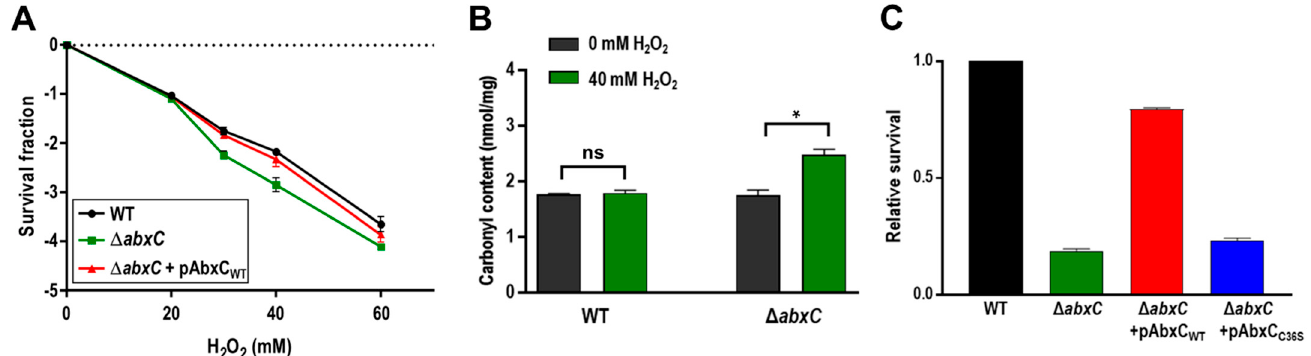
Figure 3. Effects of abxC mutation on H 2 O 2 resistance. ( A ) Survival of Δ abxC exposed to H 2 O 2 . WT, Δ abxC , and Δ abxC harboring pAbxC WT that encodes the wild-type AbxC were treated with H 2 O 2 at the indicated concentrations for 1 h. The survival fraction was calculated by dividing the CFU of H 2 O 2 -treated cells by the CFU of non-treated cells. Values are means and standard deviations of two independent experiments conducted in duplicate. ( B ) Protein carbonylation of Δ abxC in response to H 2 O 2 . After treatment of 40 mM H 2 O 2 for 1 h, the carbonylated protein contents of WT and Δ abxC were measured by the 2,4-dinitrophenylhydrazine (DNPH) assay. Data represent the means ± standard deviations of three independent experiments. Comparisons between two groups were performed by Student’s t-test (GraphPad Prism 7.04). A p -value of less than 0.01 is considered statically significant (ns; not significant, *; p < 0.01). ( C ) Complementation of Δ abxC . WT, Δ abxC , and Δ abxC harboring the pAbxC WT and pAbxC C36S plasmids, which produce the wild-type AbxC and its C36S mutant proteins, respectively, were treated with 40 mM H 2 O 2 for 1 h. Survival abilities of Δ abxC mutants were expressed relative to WT survival (arbitrarily set at 1), i.e., the CFU of mutants were normalized to the CFU of WT. Data represent the means ± standard deviations of three independent experiments.